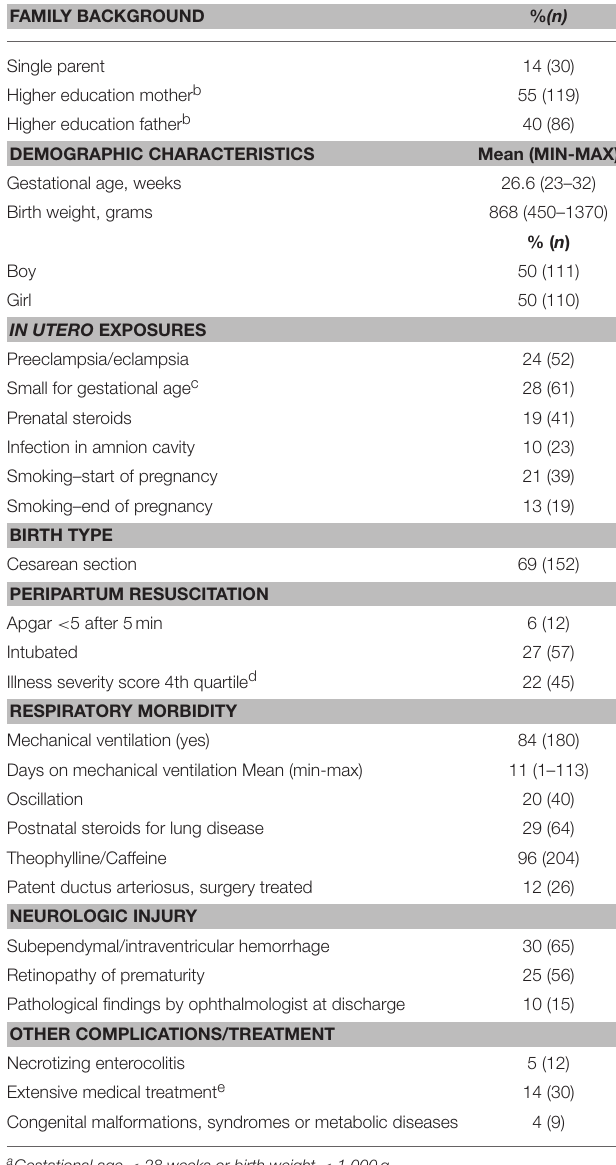
TABLE 1 | Characteristics of the 221 children who were born extremely preterm a in Norway in 1999–2000 and participated in the follow-up at 11 years of